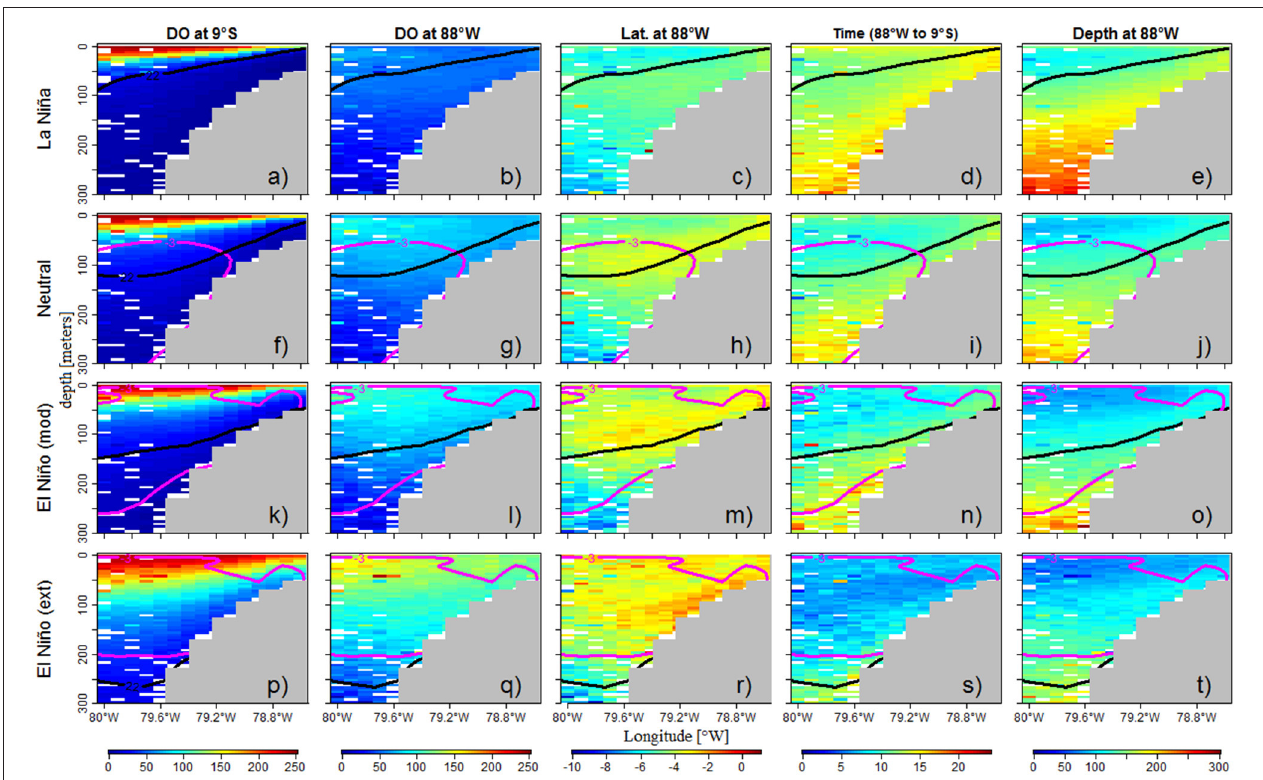
FIGURE 6 | DO cross-shore section (9 ◦ S) during LN (a) , Neutral (f) , moderate (k) and extreme (p) EN. Equatorial (from 88 ◦ W) SW properties: DO concentration (b,g,l,q) , latitude (c,h,m,r) , travel time from 88 ◦ W to 9 ◦ S (d,i,n,s) and depth (e,j,o,t) during LN, Neutral, moderate and extreme EN periods. The properties were derived from floats released during spring of the ENSO phases. The PCUC (pink line) and ZO2 (black line) also are